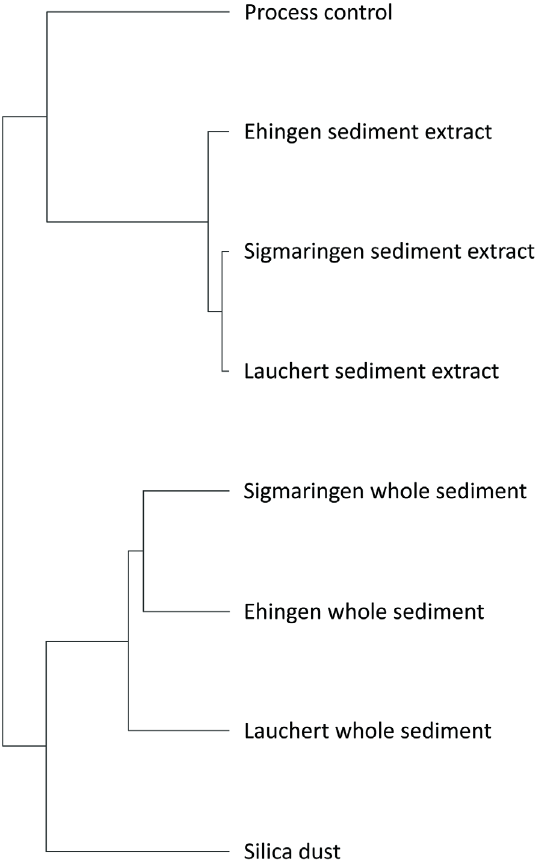
Figure 2. Dendrogram obtained by cluster anaylsis of whole sediment and sediment extract treatments as well as of silica dust and the process control treatment.